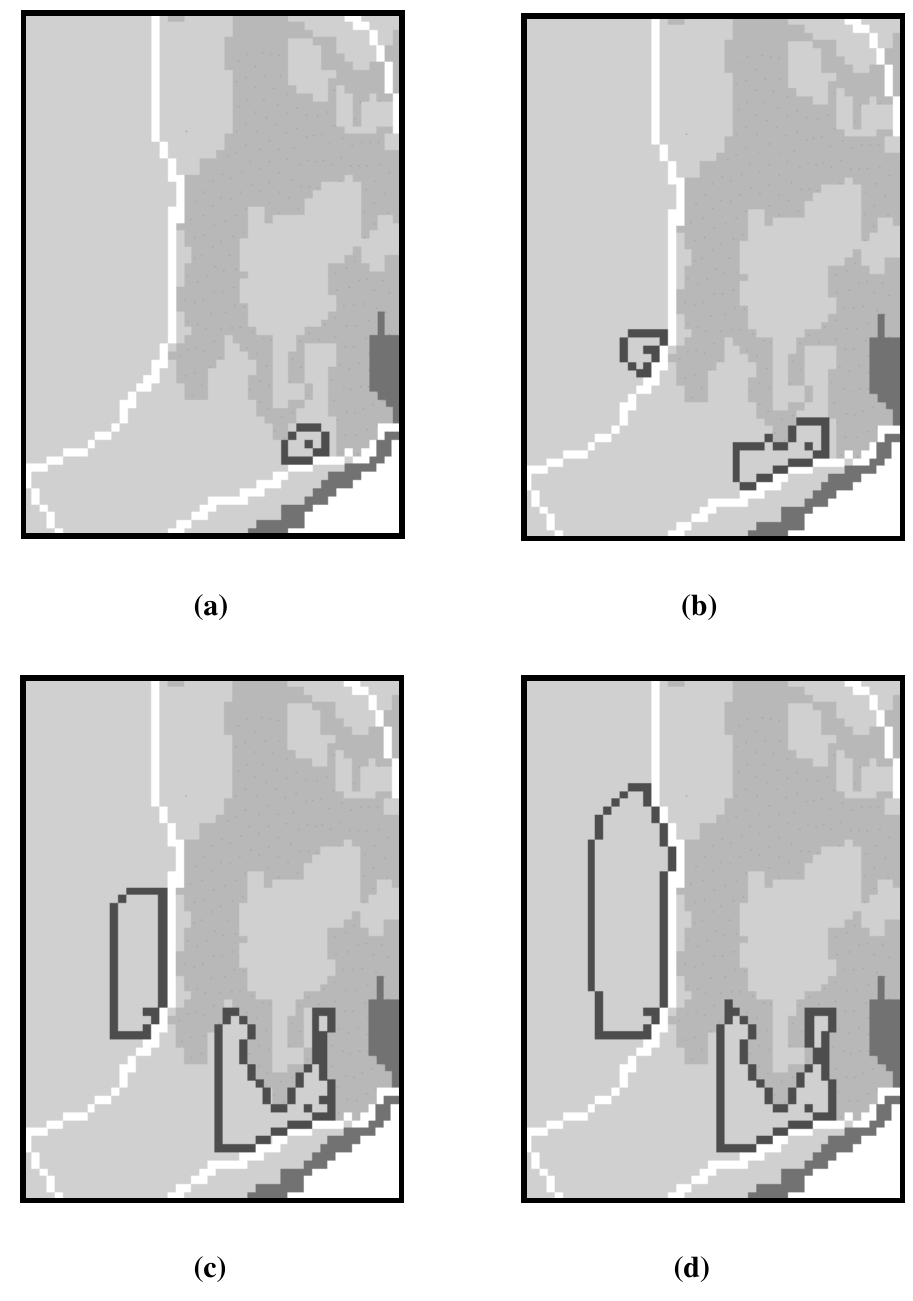
Figure 8. Fire fronts generated by the simulation model for the Trails Camp and Khongolwane areas of MGR displayed after (a) 1 hour (b) 2 hours (c) 4 hours and (d) 6